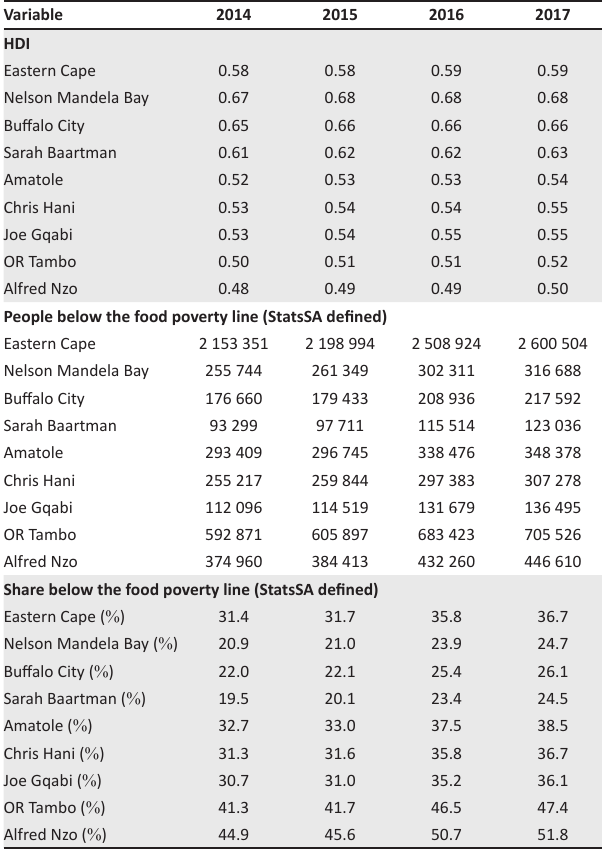
TABLE 1: Human development index and